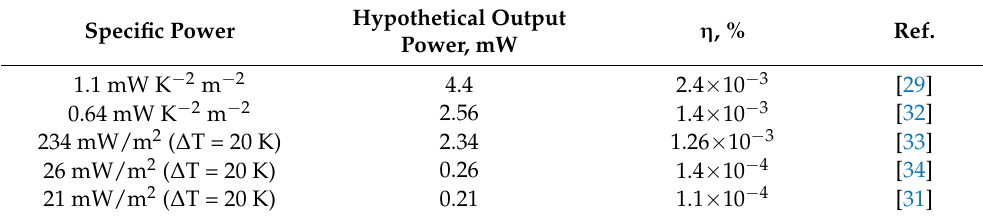
Table 1. The efficiency of gas flow energy conversion into electrical energy. Specific